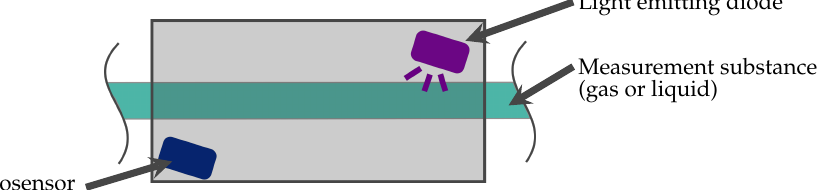
Figure 6. Schematic of an optical absorption sensor. The measurement method is based on measuring the light absorption of the measurement substance that is sent out by emitting diodes and detected by a